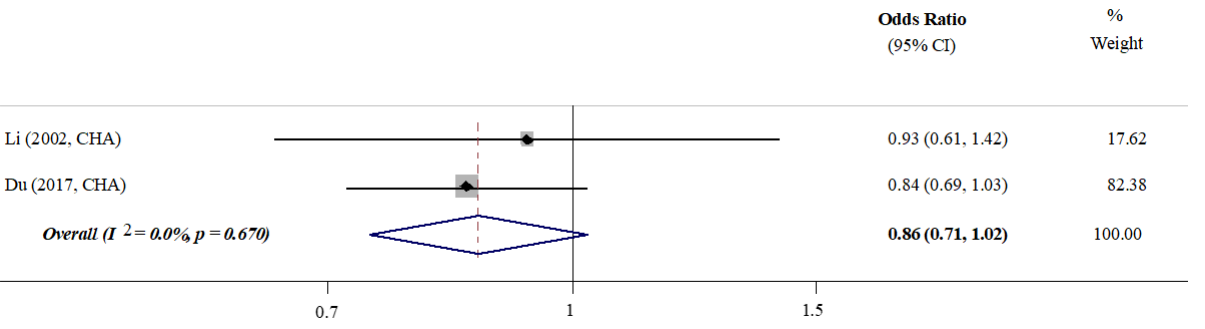
Figure 4. Meta-analysis. Gender [29,35].